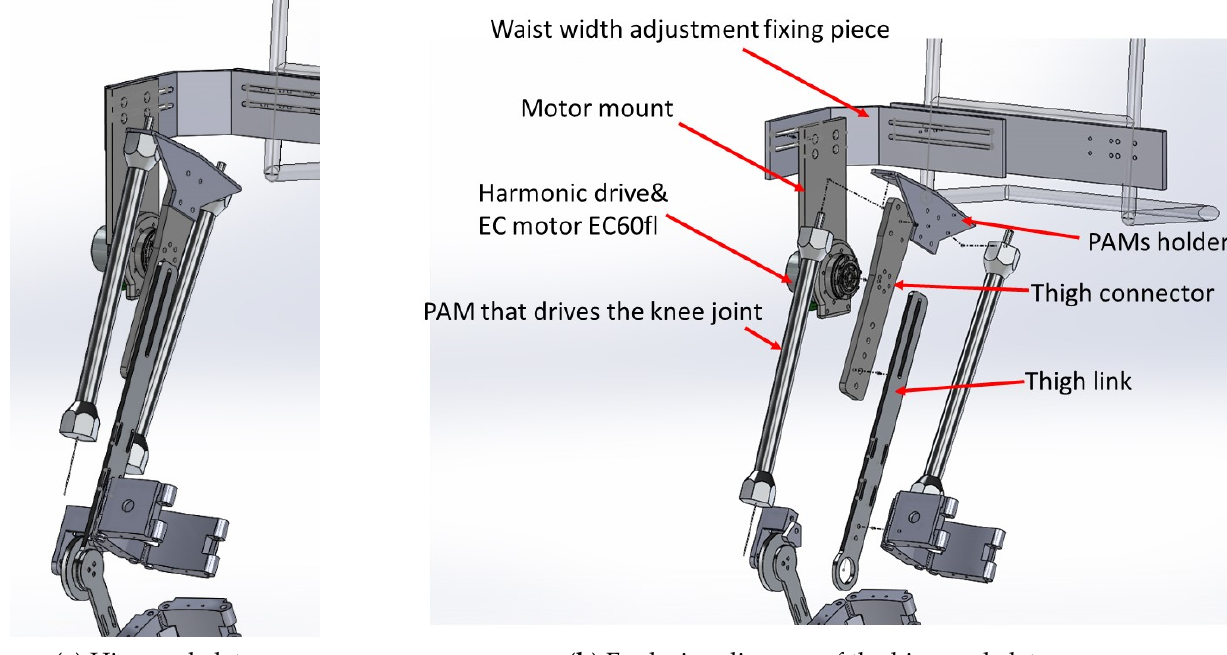
Figure 2. Hip joint exoskeleton design.